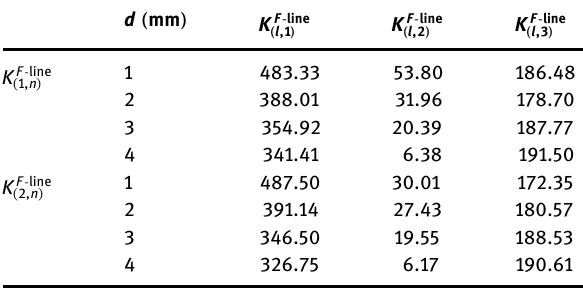
Table 5: The intensities of singularities along the front - line, ( ) - K l nF ,line